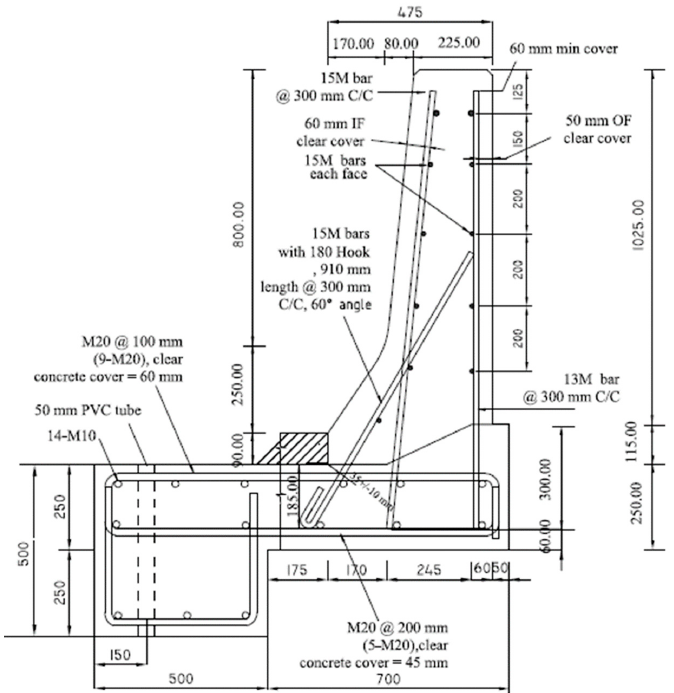
Figure 3. Specimen # 1: Interior location of barrier connected to a cantilever slab (hooks facing the roadway). Materials 2019 , 12 , x FOR PEER REVIEW